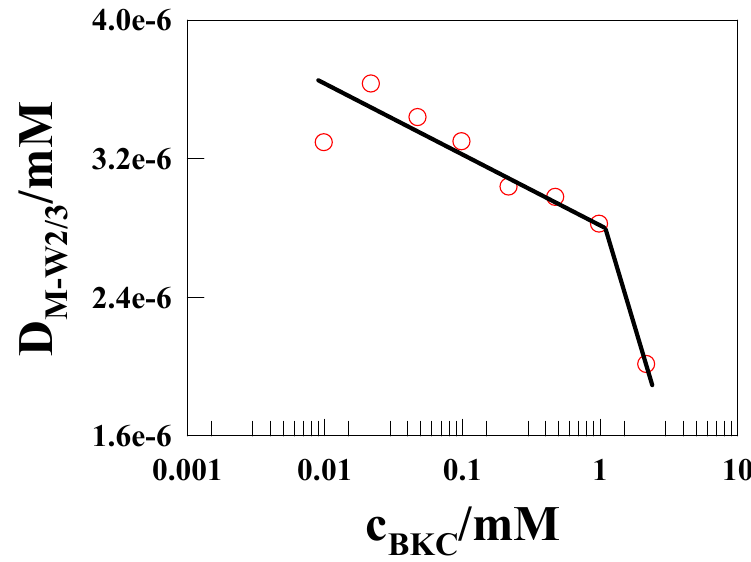
Figure 5. Diffusion coefficient of surfactant bound-[Co(II)(bpy) 3 ] 2+ from CV as a function of BKC concentration (mM).